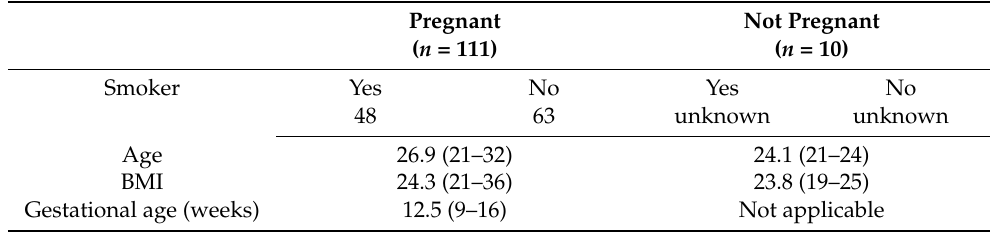
Table 1. Patient Characteristics. Age, BMI and Gestational Age presented as mean and interquartile range.